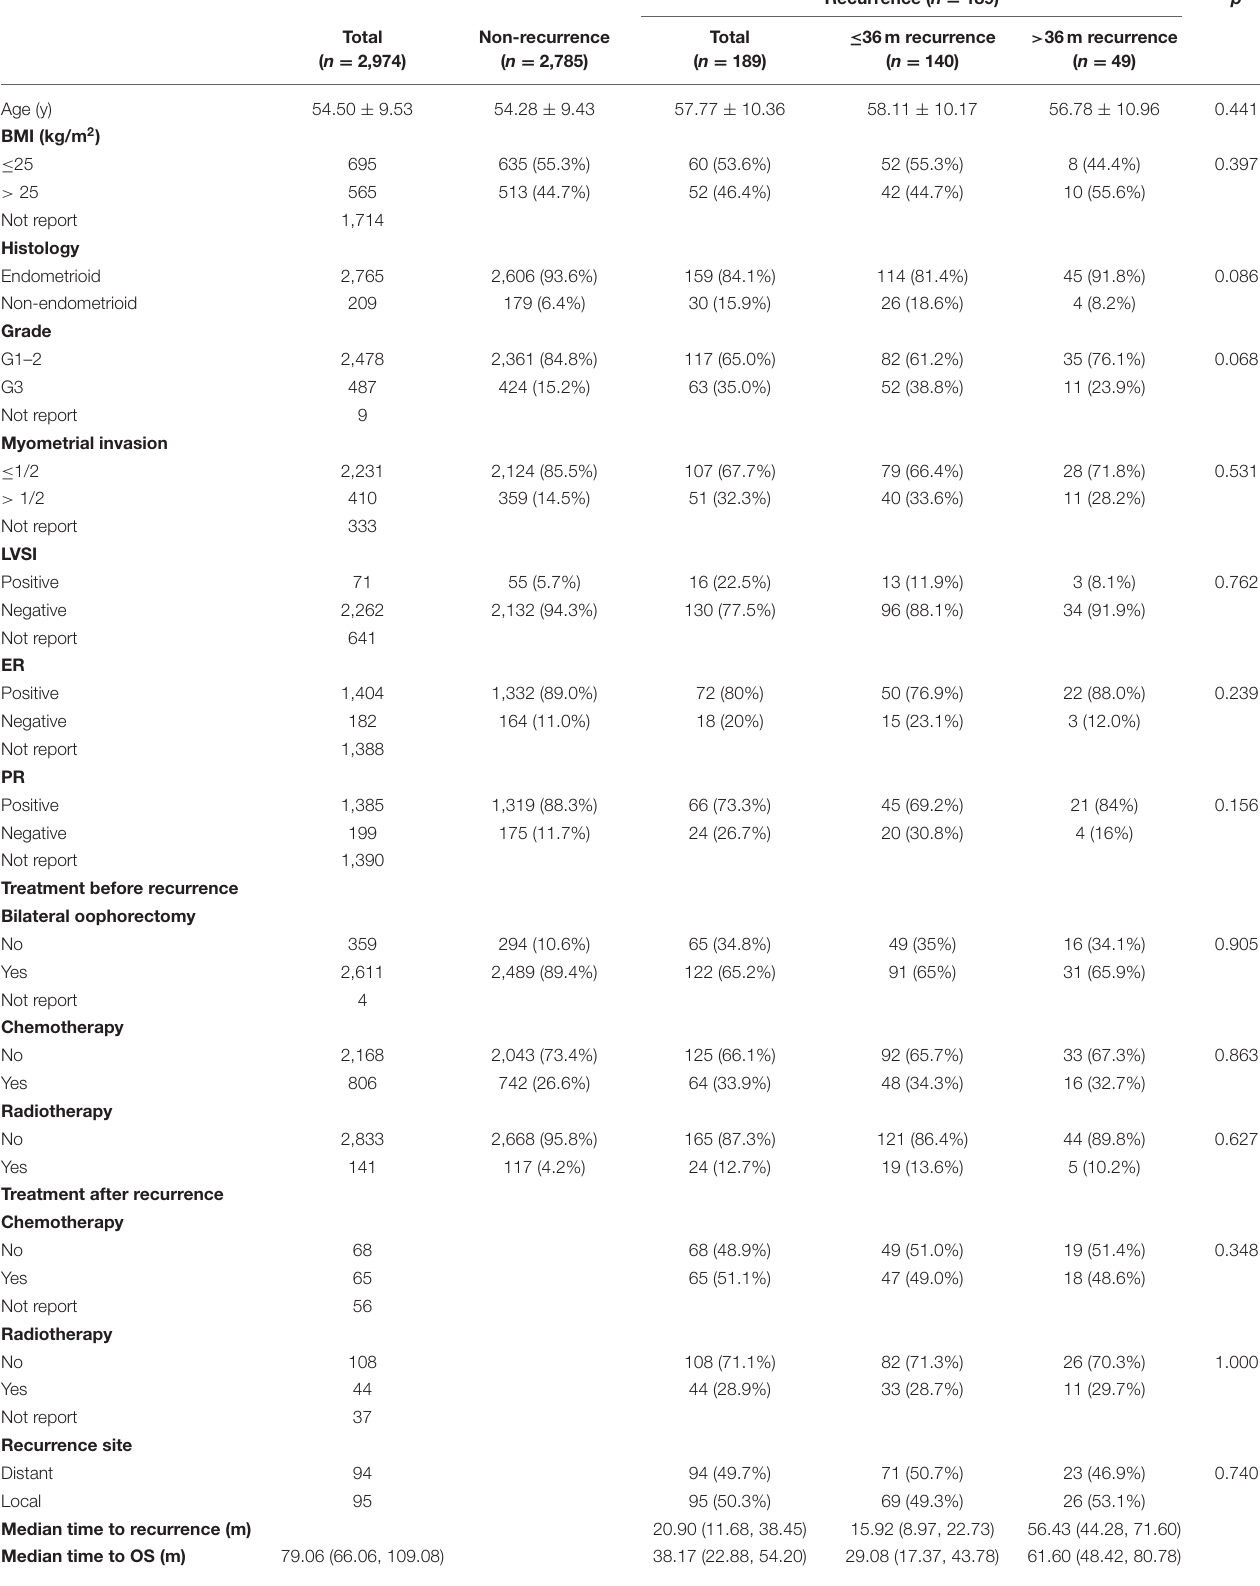
TABLE 1 | Baseline patient